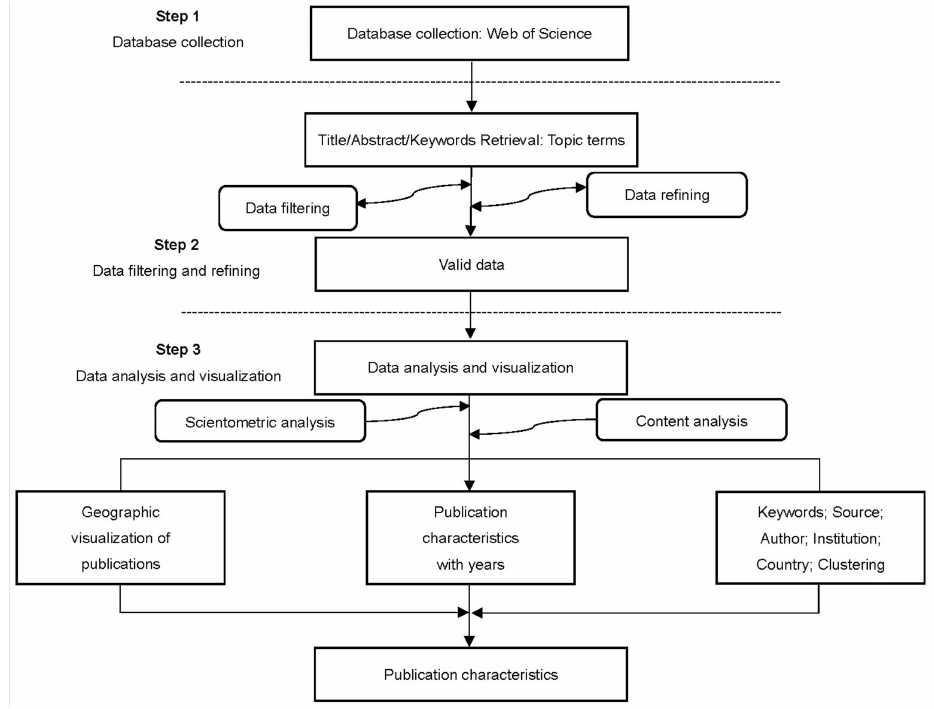
Figure 3. Flow chart for scientometric analysis of AI for geohazard